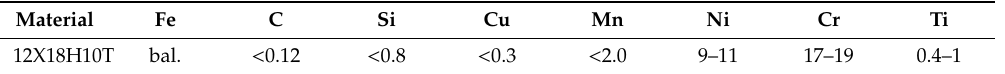
Figure 2. Scanning electron microscopy image of 12X18H10T steel powder ( a ), particle size distribution bar graph ( b ). Table 1. Chemical composition of the 12X18H10T steel,